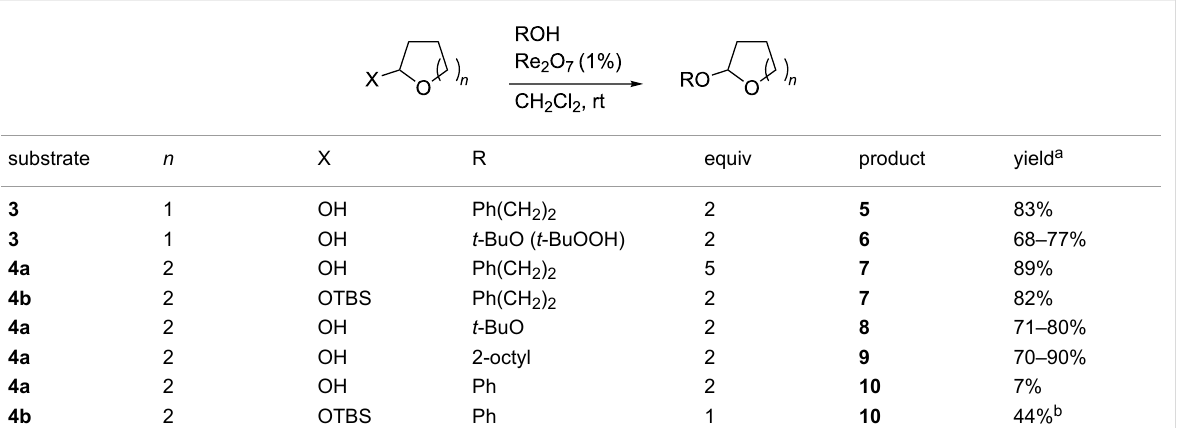
Table 2: Transetherification of